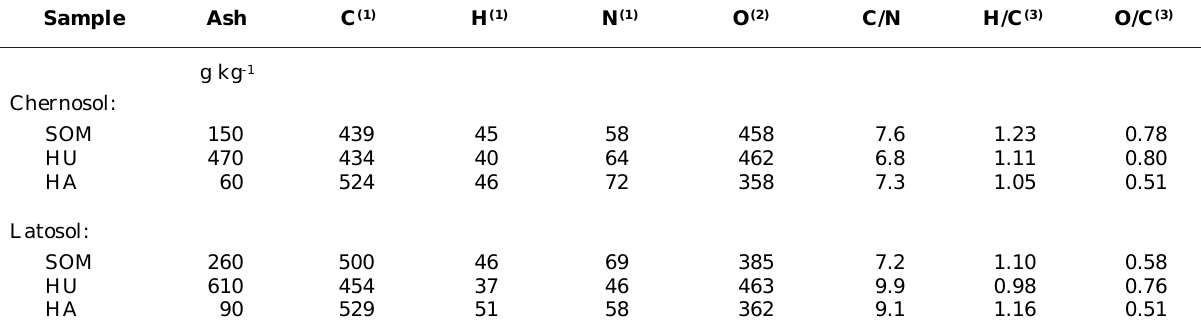
(1) Ash-free basis. (2) Calculated by difference of 1.000 g kg -1 . (3) Atomic ratio.